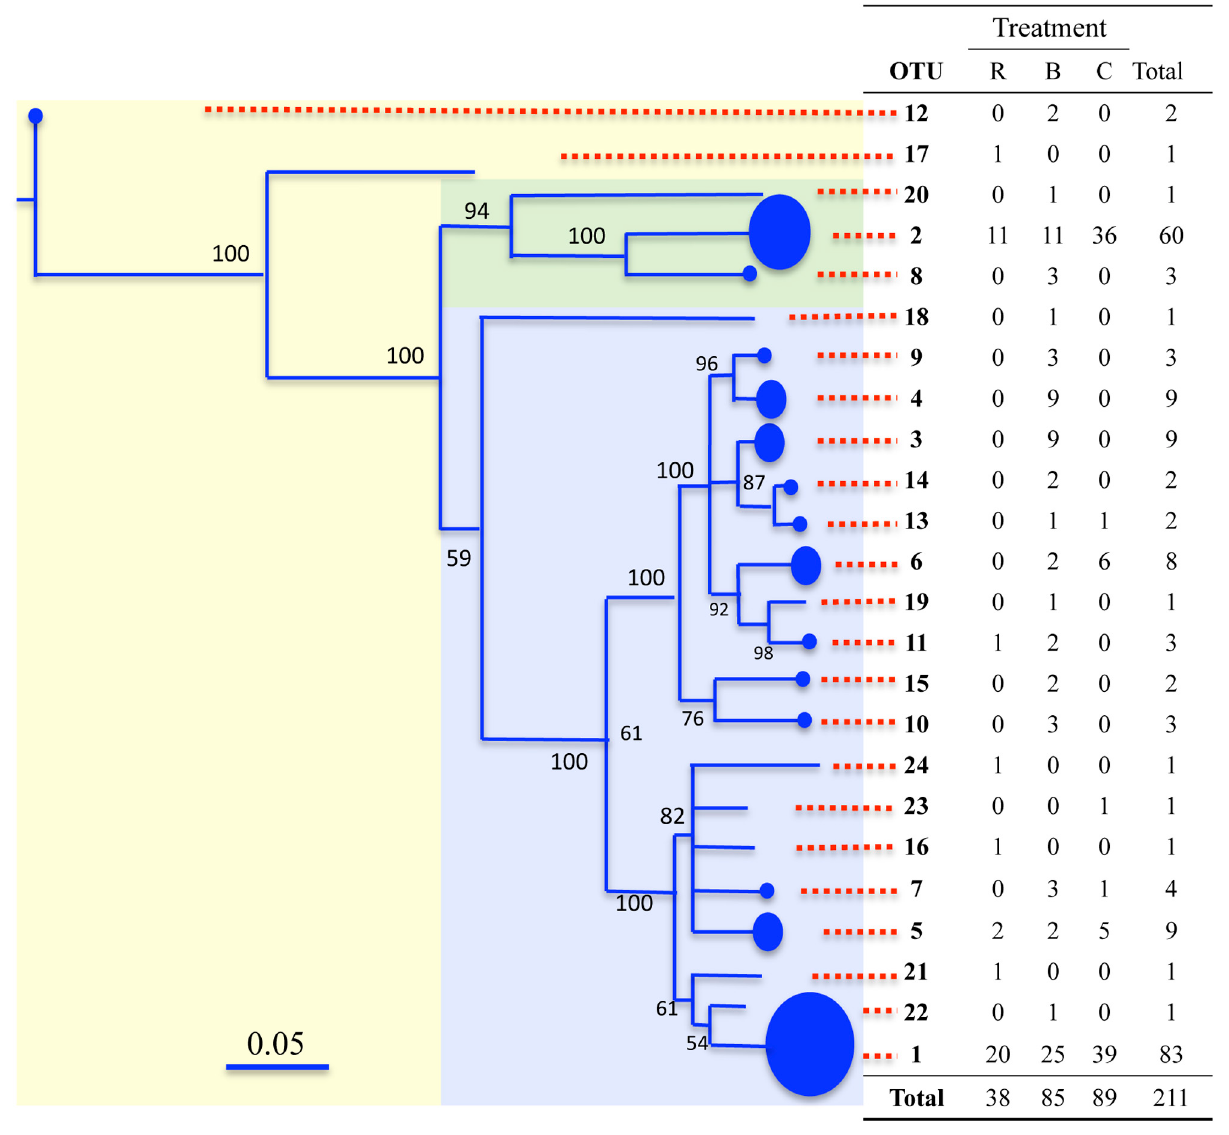
which are given in the table. Bare tips indicate single sequences. Abbreviations in the table are: R, rice; B, bagasse and C, coffee. In the latter two, the sheep and cow manure treatments are pooled. Bootstrap values (1000 replicates) are given at